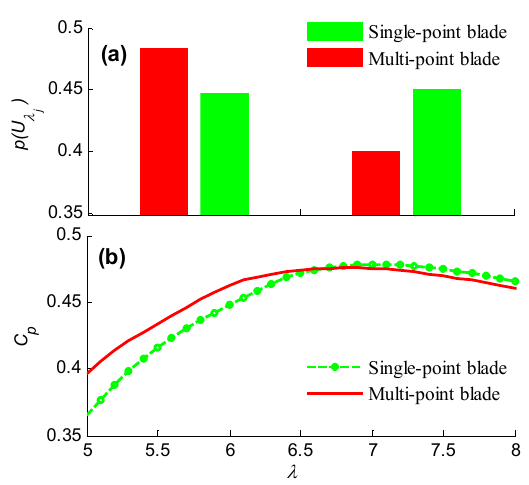
Figure 12. The proportion of the inflow wind energy: ( a ) the power coefficient; and ( b ) for the single ‐ point and multi ‐ point blades.